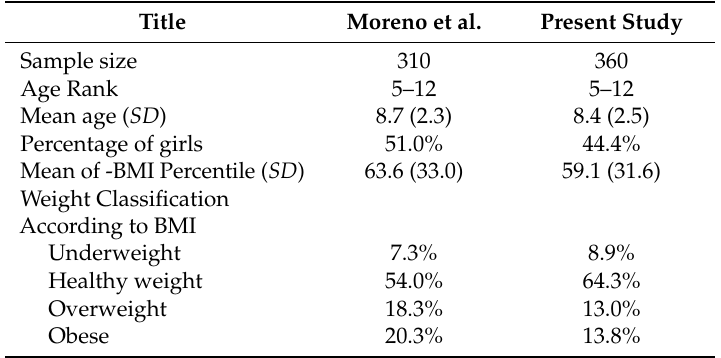
Table 1. Comparison of the present study and Moreno et al. [14] sample